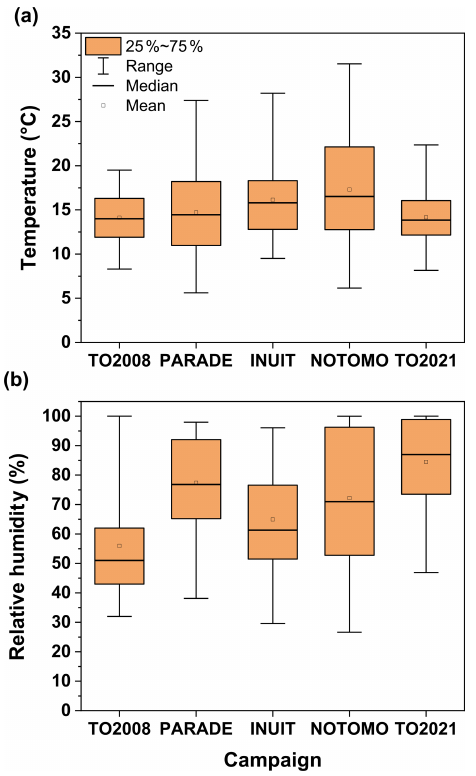
Figure 12. Distributions of (a) temperature and (b) relative humid- ity during five campaigns at the Kleiner Feldberg between 2008 and 2021. Boxes represent the range between the first and third quar- tiles, and whiskers denote the full range of values.